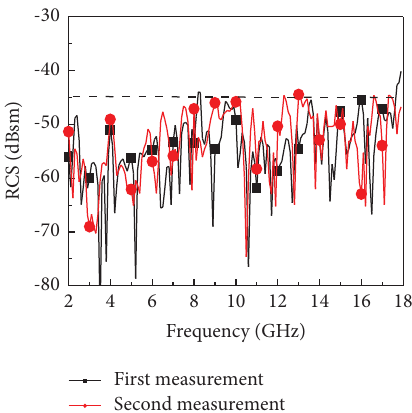
Figure 8: Background level RCS measurement results.